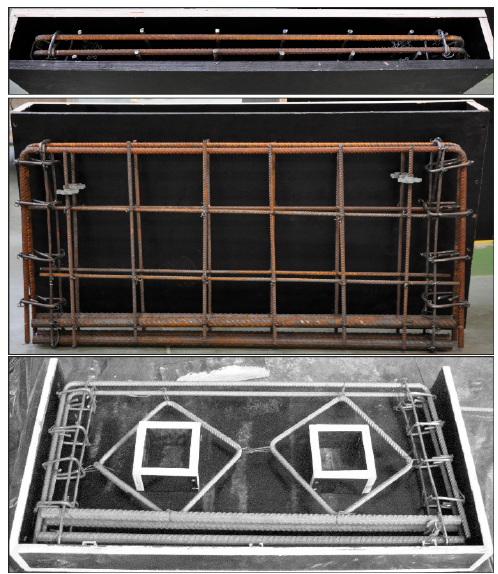
Figure 2. Fabrication of internal steel bars for deep beams DB1, and deep beams with two symmetrically located openings DBO2,